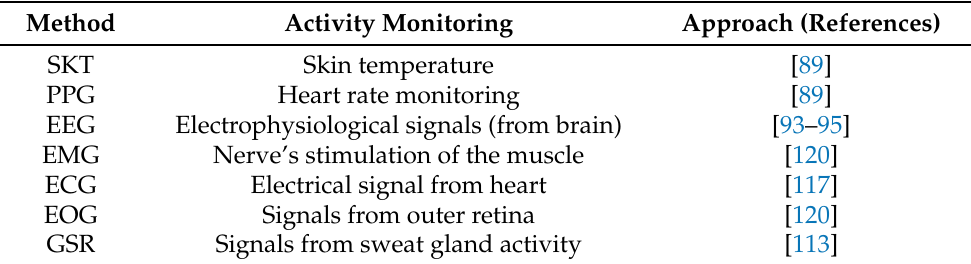
Table 1. Summary of major methods for activity monitoring (focused human emotion recognition) and corresponding approach used (reference articles).